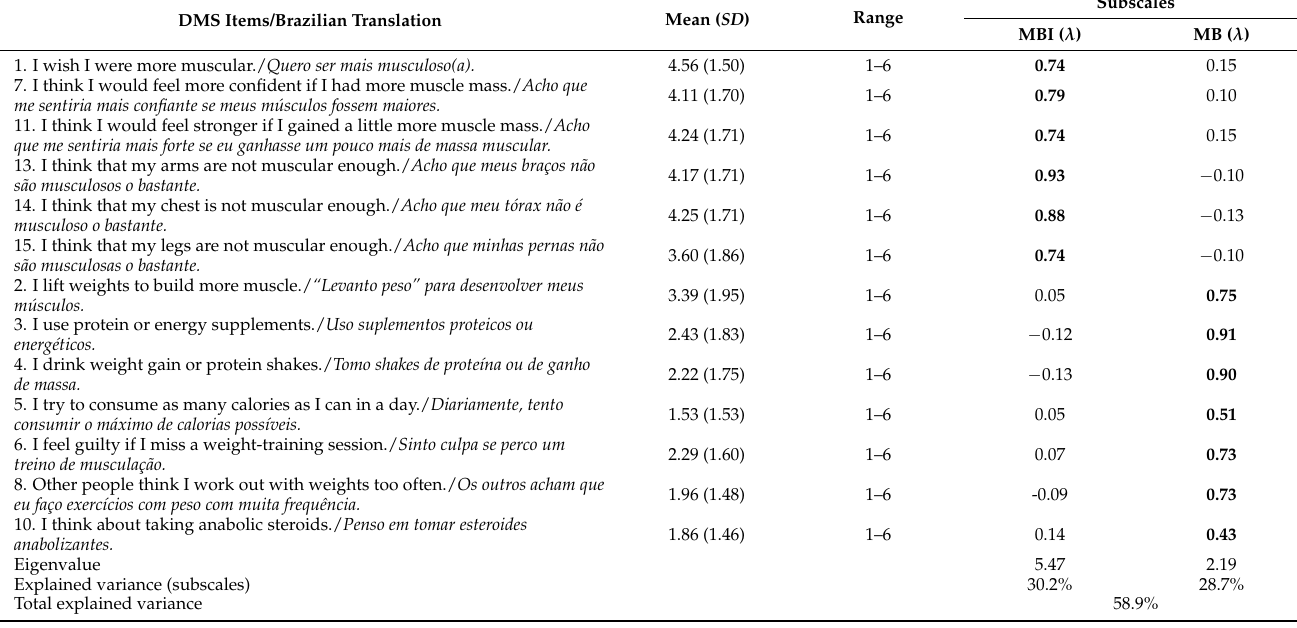
Table 2. Descriptive statistics and factor loadings for EFA of the Drive for Muscularity Scale (DMS) of Brazilian cisgender gay and bisexual adult men.